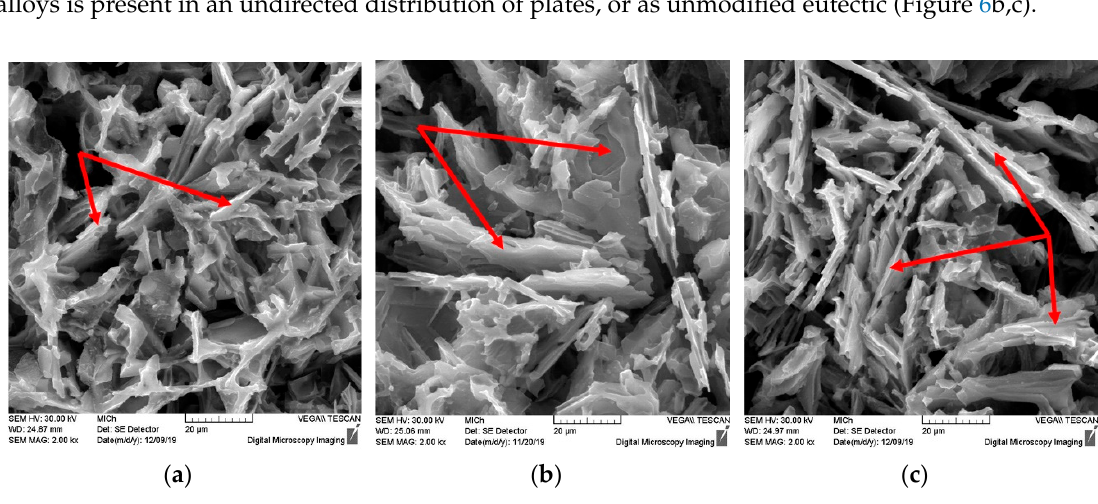
Figure 5. Changes of eutectic Si, Cu-rich and Fe-rich phases of AlSi9Cu3 alloy depend on the ratio of returnable material in the batch after natural aging, SEM; ( a ) 20–80 alloy, ( b ) 50–50 alloy, ( c ) 90–10 alloy.